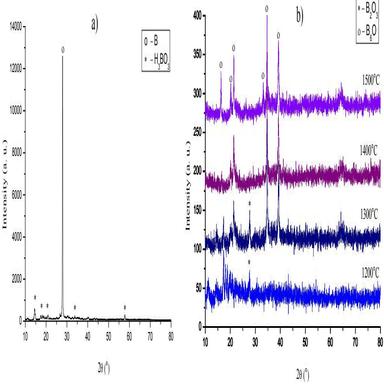
X-ray diffraction patterns of (a) as-prepared starting material and (b) samples after calcination at different temperatures (1200 - 1500°С).